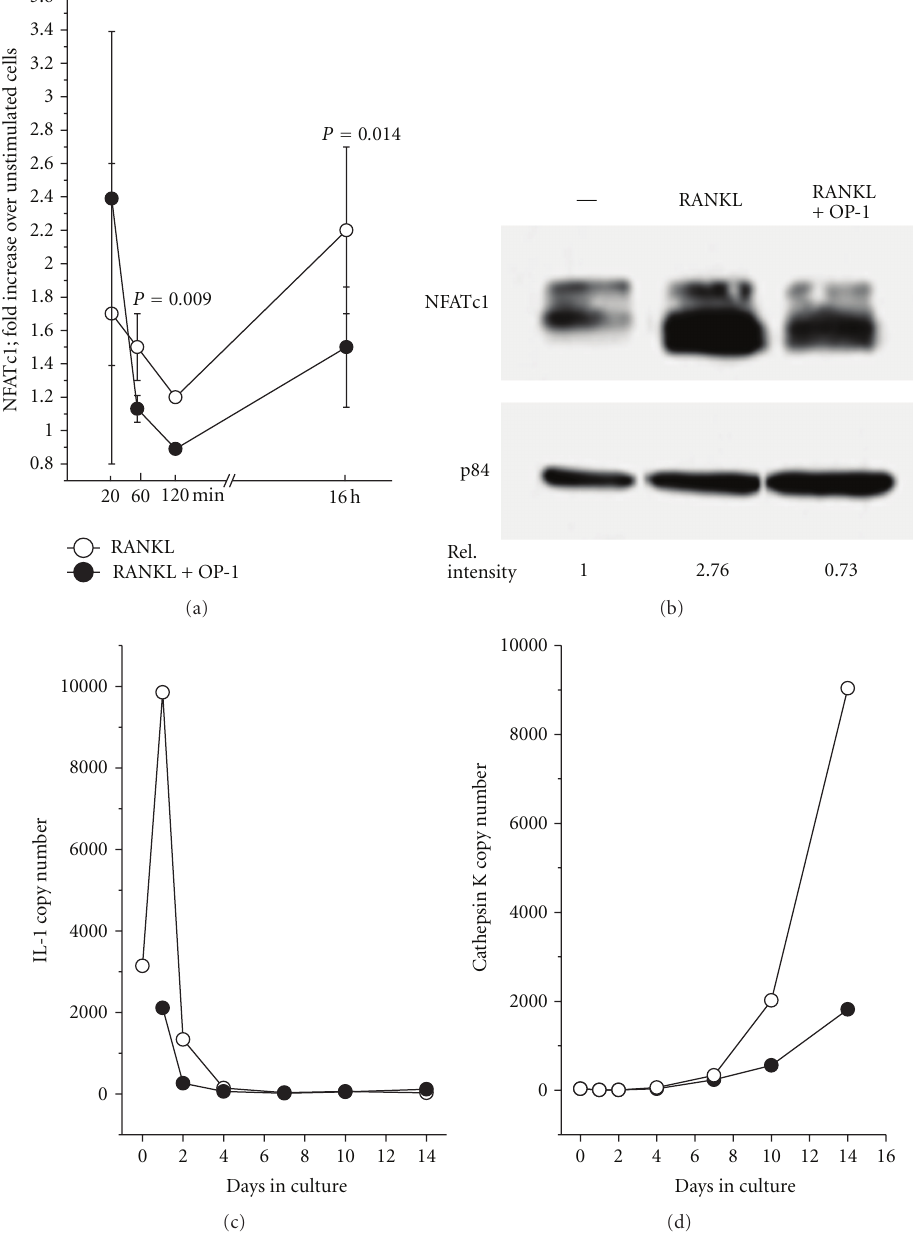
Figure 4: E ff ect of OP-1 on NFATc1: (a) NFATc1 in the nuclear fraction was determined by ELISA of monocytes treated with RANKL ( ◦ ), or RANKL + OP-1 ( • ) for the times indicated. Data derived from experiments with cells of four individual donors are shown (with exception of the time point 120min), and di ff erences of the mean values were calculated using t -test. (b) By Western blotting, the e ff ect of OP-1 was confirmed (data for 24 h are shown). (c), (d) Various times after onset of culture, IL-1 and cathepsin K specific transcripts were determined by quantitative PCR ( • ); the open symbol ( ◦ ) shows the parallel experiment with addition of OP-1 (data are mean of duplicates; one of two experiments is